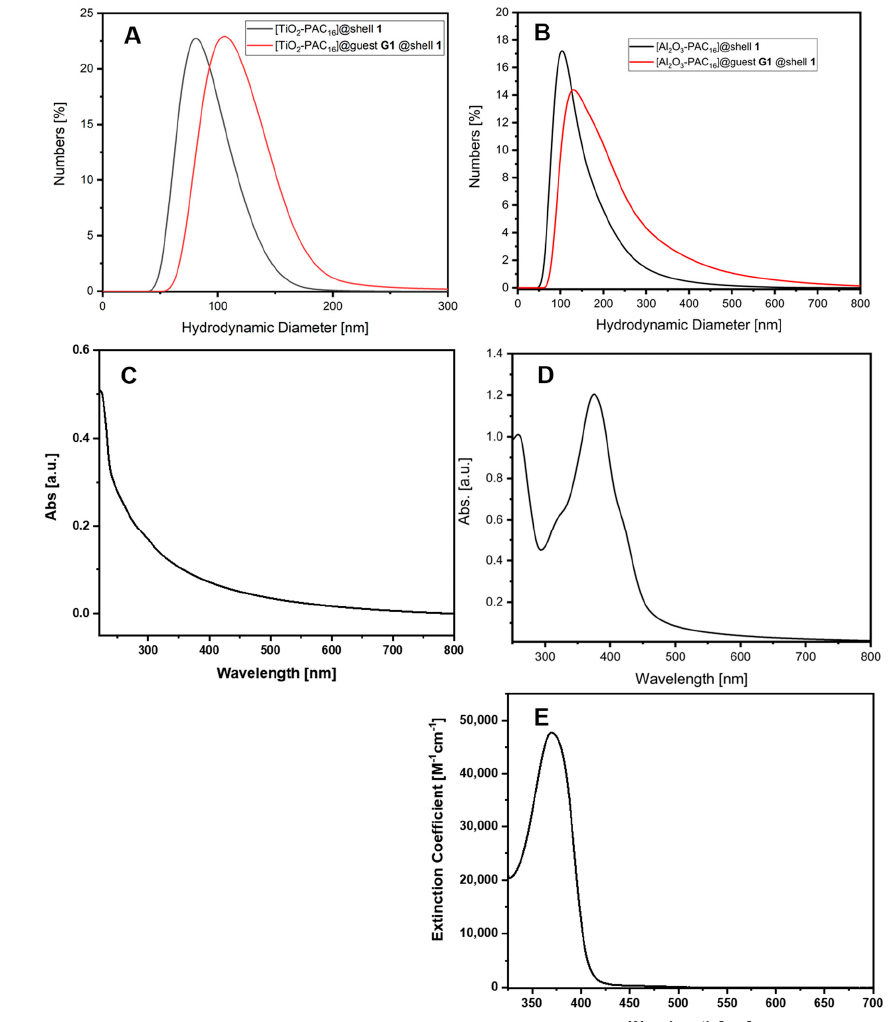
Figure 2. Comparison of the hydrodynamic diameter of the unloaded nanocarriers and the nanocarriers loaded with G1 (quercetin): ( A ) TiO 2 nanocarriers, ( B ) Al 2 O 3 nanocarriers; ( C ) UV/Vis spectrum of the unloaded nanocarrier [Al 2 O 3 -PAC 16 ]@shell 1 ; ( D ) loaded nanocarrier [Al 2 O 3 -PAC 16 ]@guest G1 @shell 1 and quercetin in acetone ( E